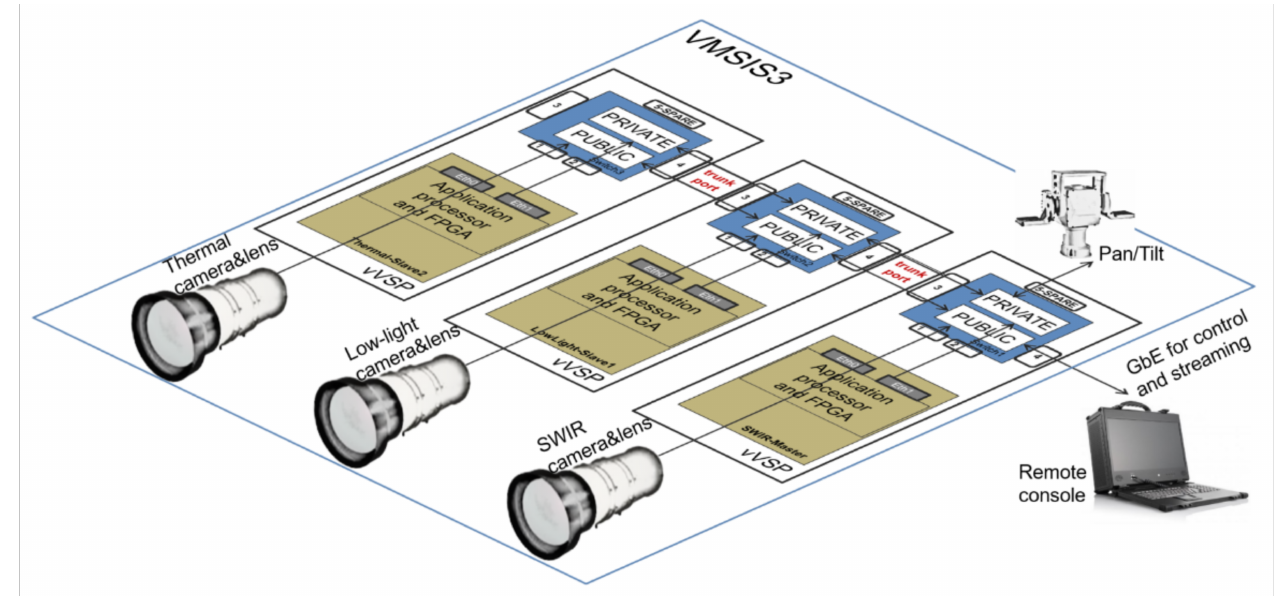
Figure 12. VVSP network topology.